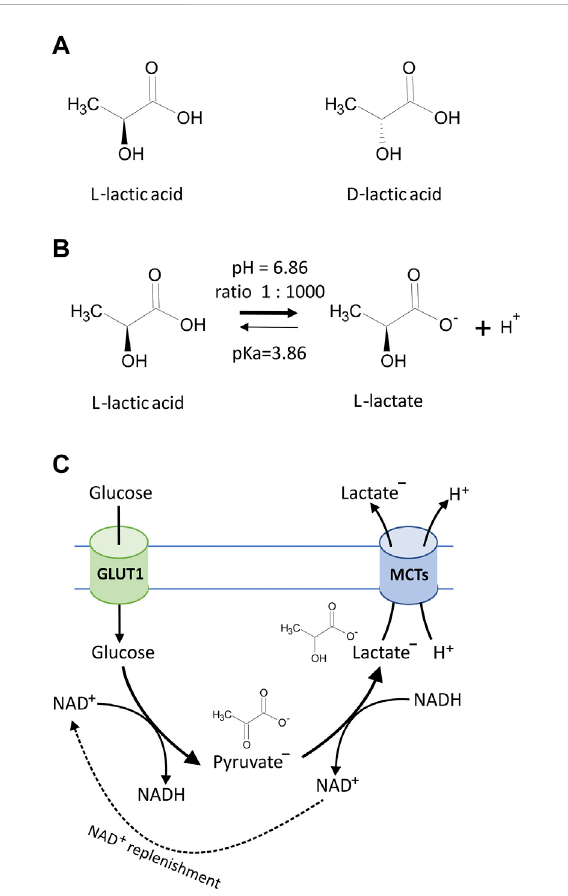
FIGURE 1 (A) Chemical structures of lactic acid isomers, L-lactic acid and D-lactic acid. (B) Lactic acid is a weak organic acid with pKa = 3.86, and in biological systems, lactic acid undergoes ionization to produce carboxylate anion CH3CH(OH)COO − (lactate) and H + . Under cellular physiological pH (7.0 – 7.4), the lactate to lactic acid ratio exceeds 1,000:1 according to the Henderson – Hasselbalch equation, which describes the mathematical relationship between the pH value, the log of the acid dissociation constant (pKa), the molarity of the acid, and the molarityofthebase[pH=pKa+log 10 (conjugatebase/weakacid)]. (C) The simpli fi ed diagram of lactate generation and excretion in eukaryotic cells. Glucose transport across the cell membrane is facilitated by glucose transporters (GLUT1). In the cytosolic compartment of the cell, glucose is converted to pyruvate via a series of intermediate metabolites to yield a net of 2 molecules of adenosine triphosphate (ATP) and reduced nicotinamide adenine dinucleotide (NADH). Cellscarryinganaerobicrespiration(hypoxic conditions and tumor cells) subsequently reduce pyruvate to lactate and thus regenerate the pool of NAD + . Excretion of resulting lactate along with protons (H + ) is facilitated by monocarboxylate transporters (MCTs) according to substrate and H + concentration